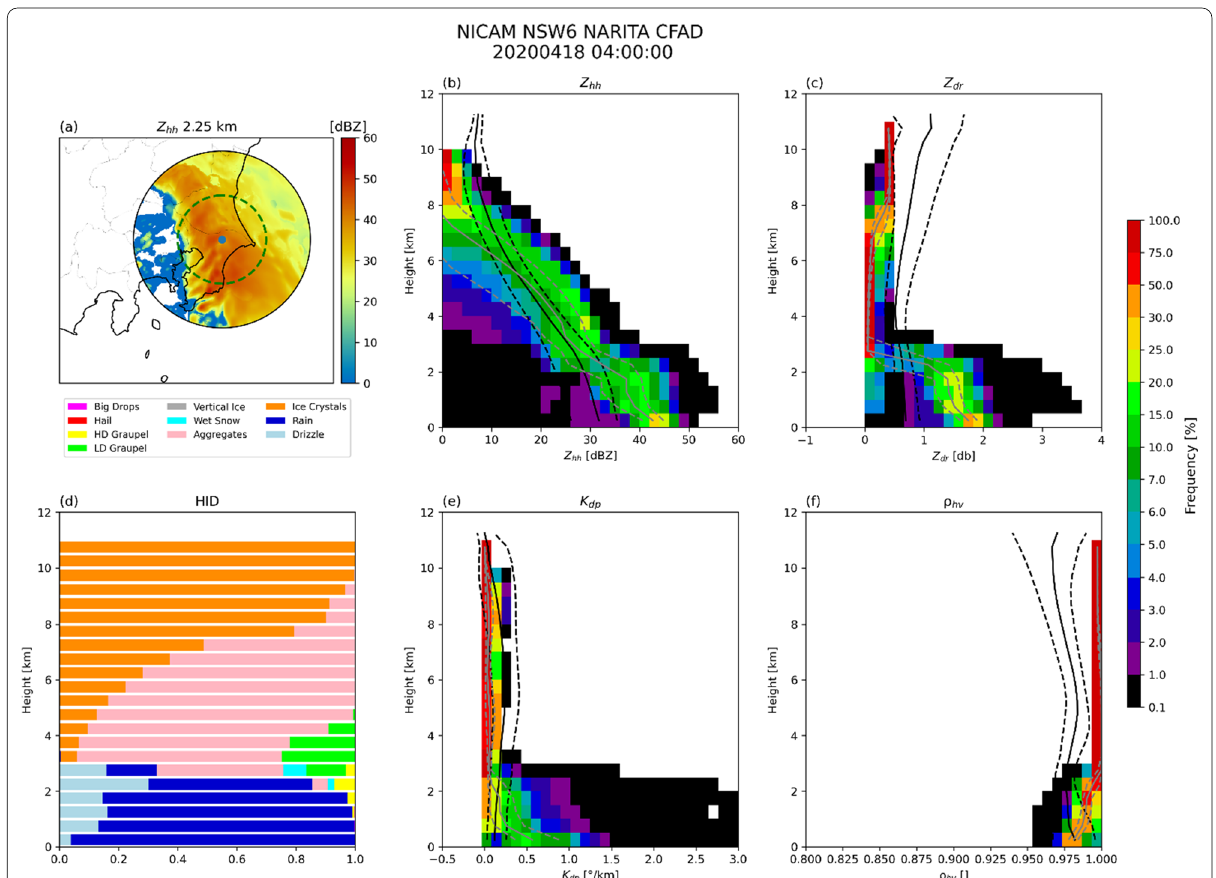
Fig. 15 The same as Fig. 14, but for the NICAM-NSW6 simulation. The black solid curve is the median, the dashed curves are the 25 and 75 percentiles of the observed PDF at each altitude, and the gray curves are those for the NICAM-NSW6